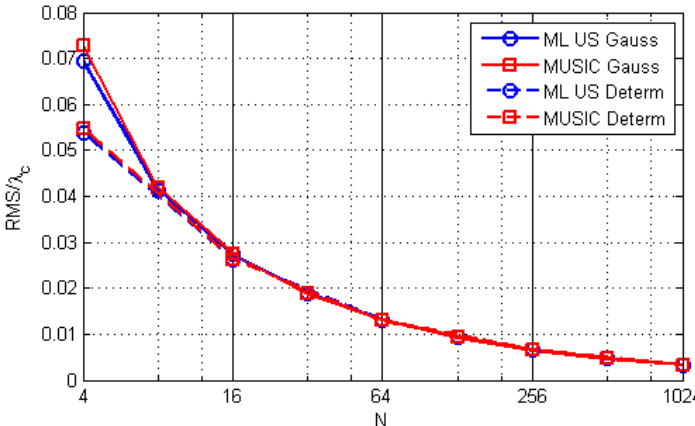
Figure 12. The RMSE/ λ c vs. N for different methods and